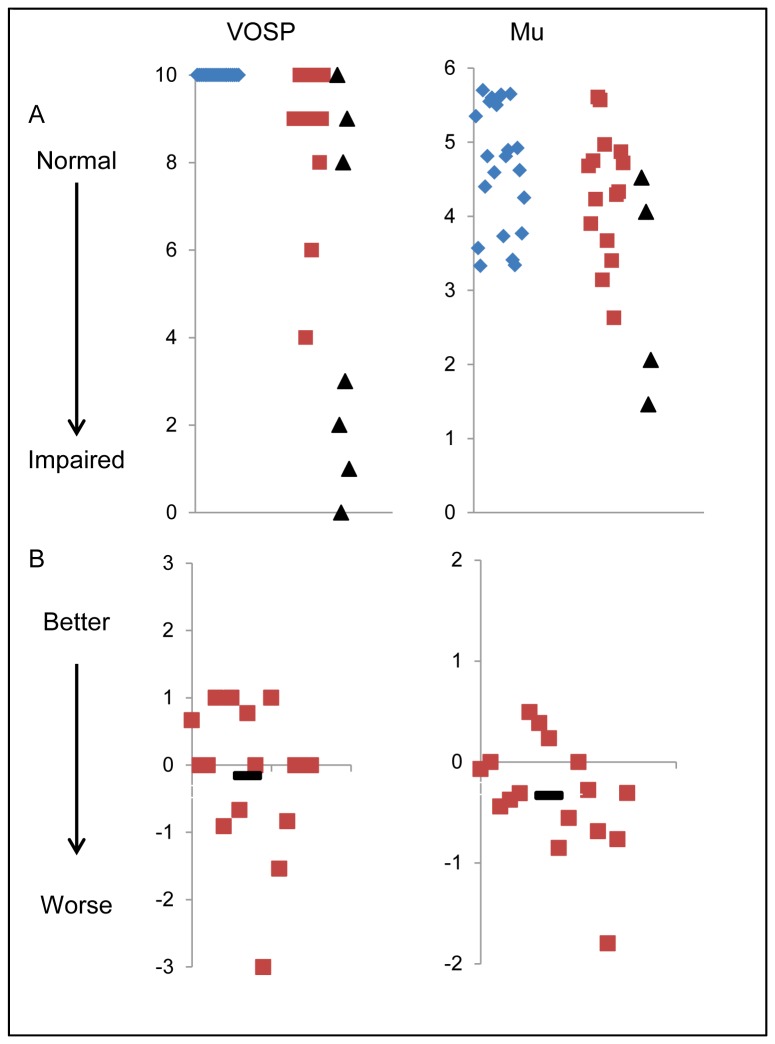
Baseline scores and annualised rates of change for visual and oculomotor tests.Tests are named at the top of each column. VOSP is the Visual Object and Space Perception battery and mu is the reciprocal of the latency as measured by saccadometry. Row A shows baseline scores on the test. Blue diamonds are controls, red squares are patients and black triangles mark the baseline score for patients who died before interval testing. A lower value on the y axis for the mu graph corresponds to a lengthening of latency between stimulus presentation and saccade initiation. Row B shows the difference in score between baseline and interval, in those patients who completed both assessments. The score has been adjusted so that it shows the change in score over twelve months, irrespective of how far apart the assessments were. Negative values represent worsening of function. In both sets of graphs, the x axis represents a nominal value. In line A the x axis is arranged so that controls are on the left, patients who completed interval assessments are in the middle and patients who did not complete the interval assessment are on the right. In line B the scores are arranged randomly.